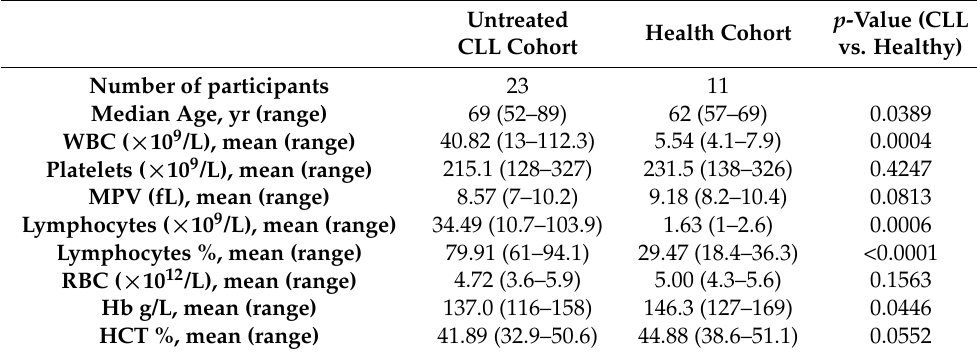
p -Value (CLL Untreated Health Cohort vs. Healthy) CLL Cohort